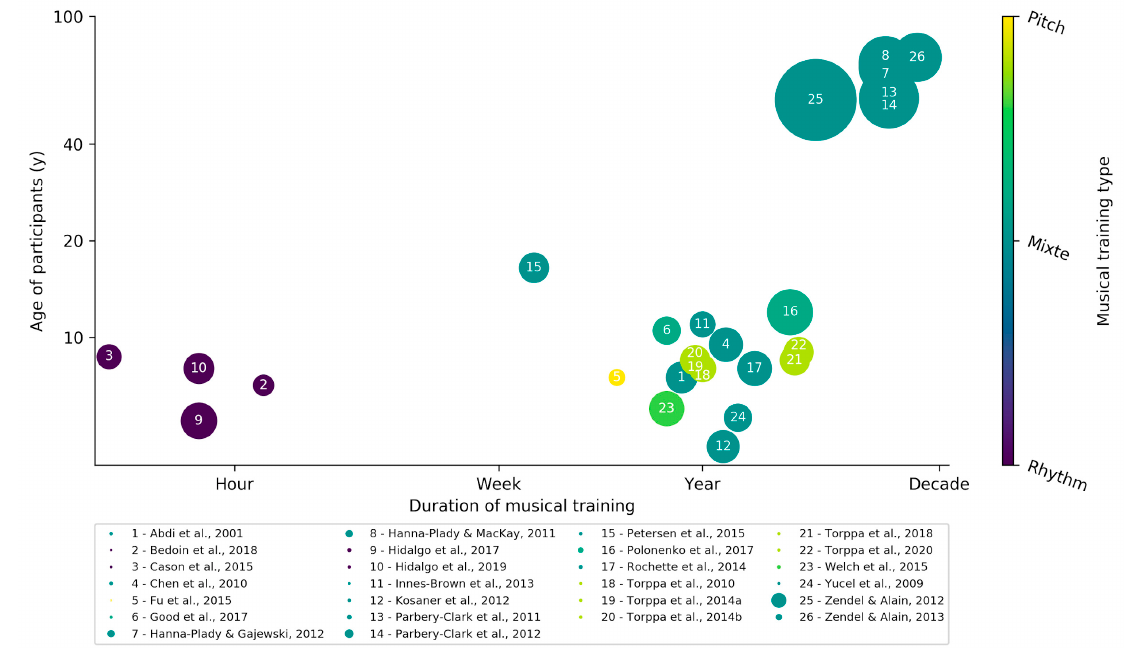
Figure 1. Review of musical training protocols reported in scientific papers [7,24–48]. Each circle represents one study, plotted as a function of the average duration of the musical training and the average age of the participants. Color of the points indicates the content of the training, on a continuum from rhythmic only (drums only) to pitch only (songs, melodies) training. The size of the points indicates the sample size of the study (range: